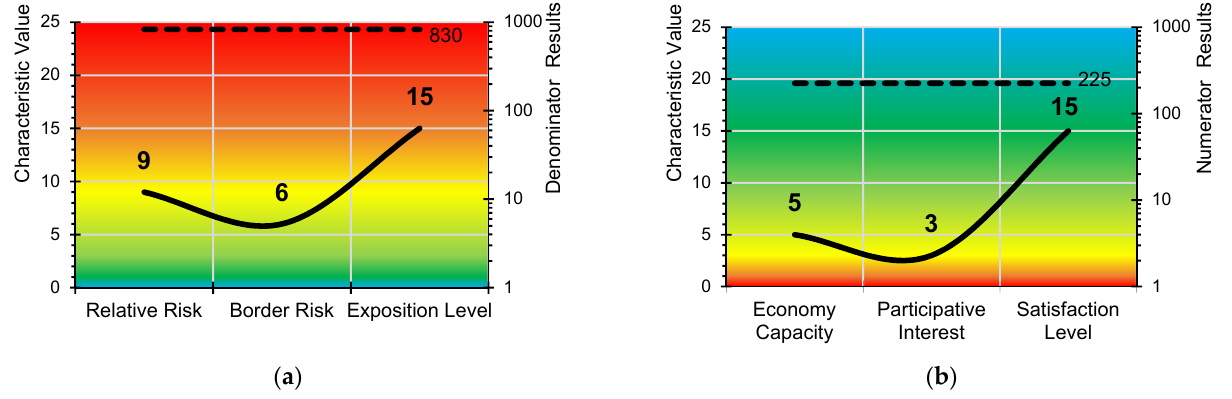
Figure 6. Cv Results in the case study: ( a ) Numerator of the Apac ; ( b ) Denominator of the Apac .